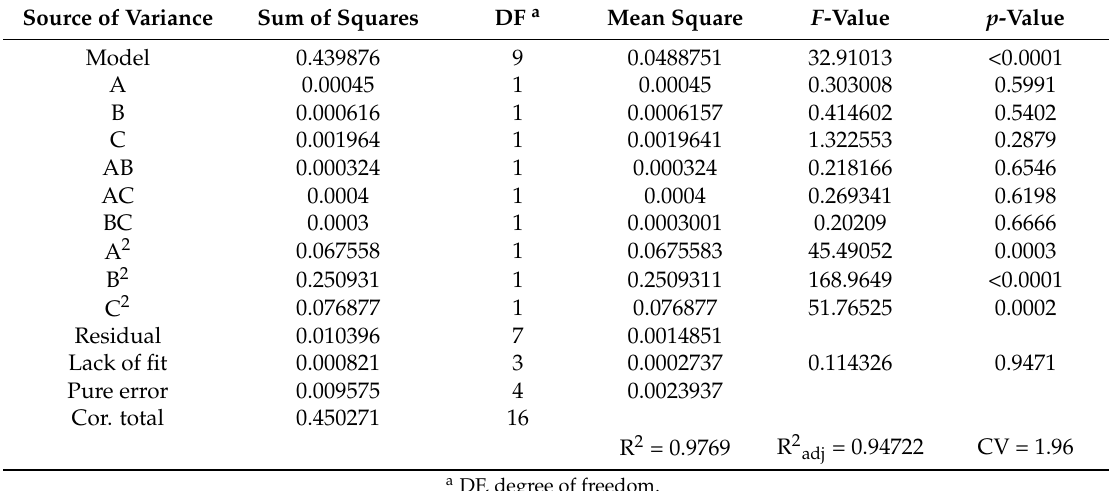
Table 1. Regression coefficient estimations and significant tests used for the quadratic polynomial model used to determine the overall EY of IOPS.